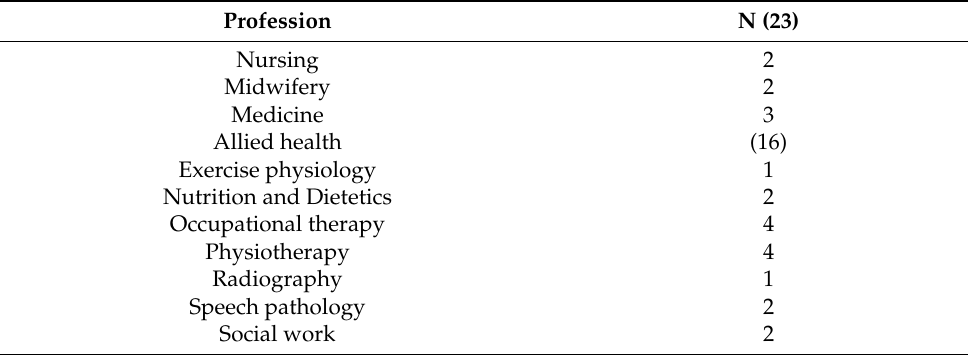
Table 1. Participants’ professional